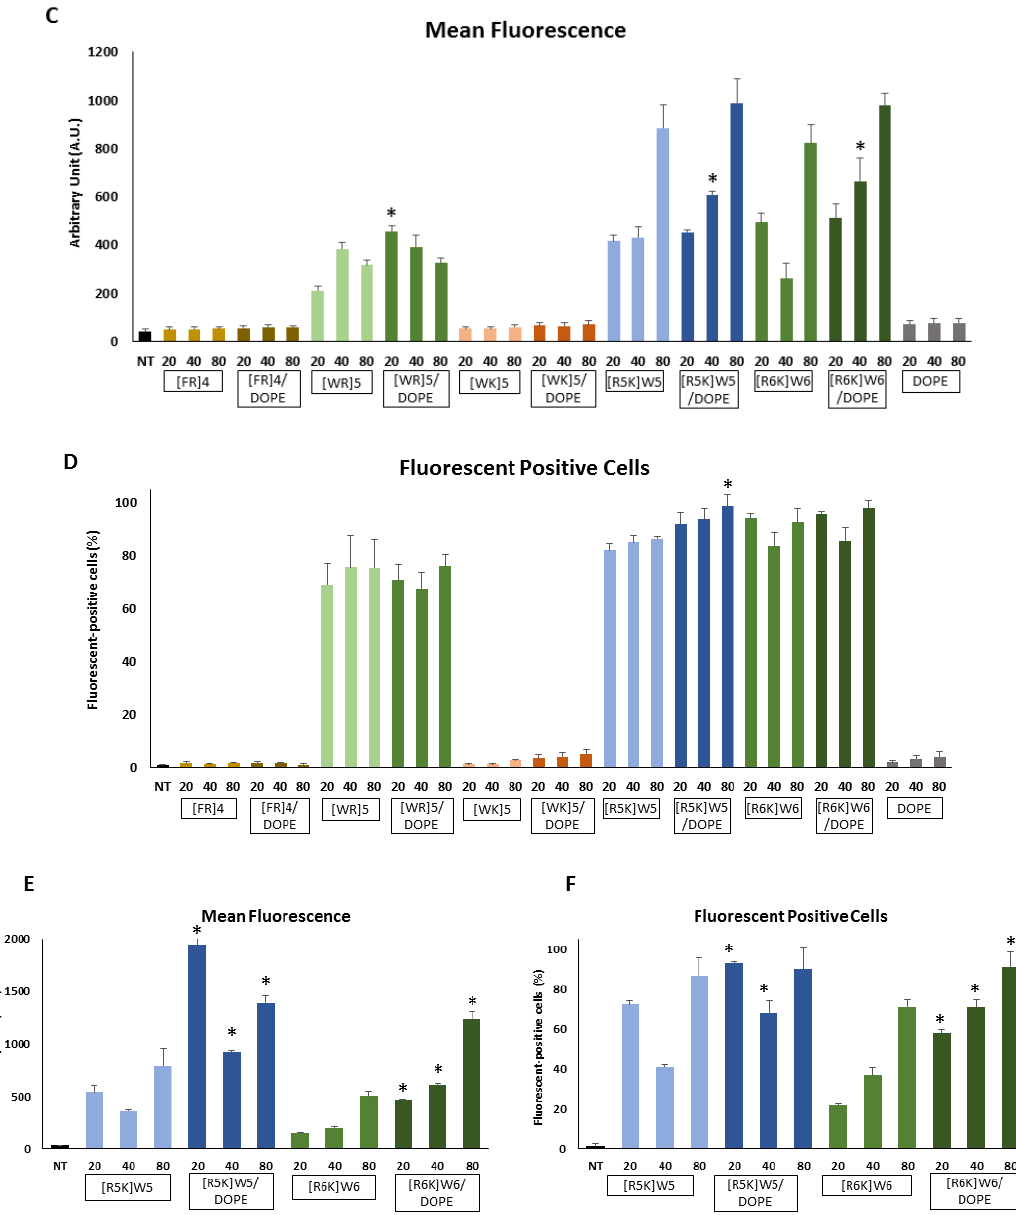
Figure 3. The e ffi cacy of siRNA cell internalization with designed pepties (with and without addition of DOPE) in MDA-MB-231 Cells ( A , B ), MDA-MB-468 ( C , D ), and AU565 cells ( E , F ; only for [R 5 K]W 5 and [R 6 K]W 6 with di ff erent N / P ratios (20:1, 40:1, and 80:1) (Flow cytometry; n = 3). The uptake is presented as both mean fluorescence in the whole cell population ( A , C , E ) and percentage of cells identified as fluorescent positive ( B , D , F ). The “DOPE” group represents internalization of siRNA with DOPE alone. The error bars indicate standard deviation. Asterisks indicate significant di ff erence ( p < 0.05) with the ‘without DOPE’ corresponding group.